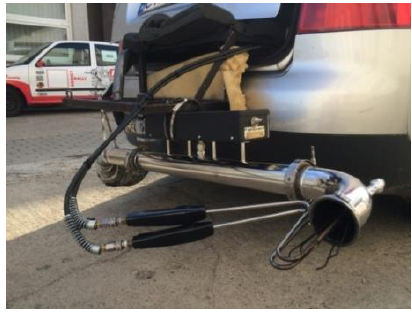
Fig. 3. Semtech EFM